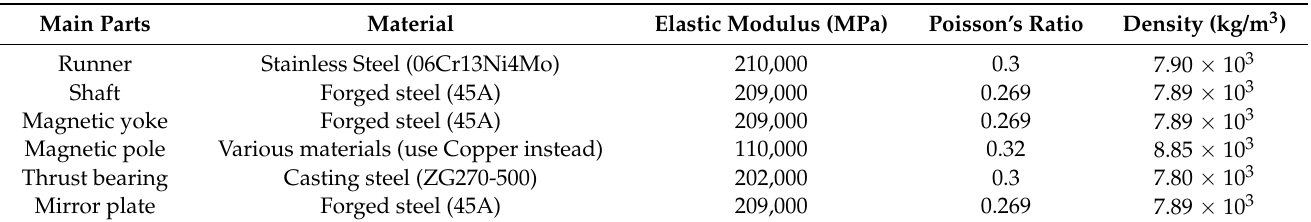
Table 3. Materials’ physical and mechanical parameters of shafting components.